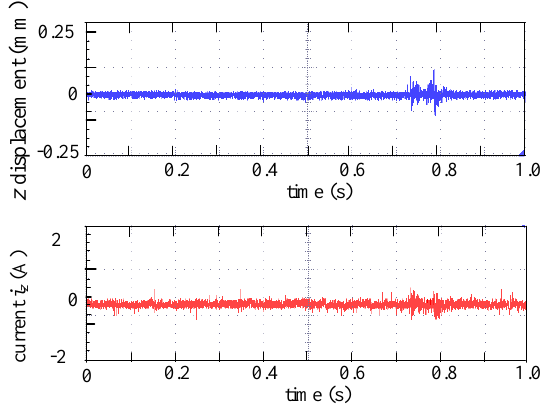
Figure 8. Waveforms of impact test in axial direction.